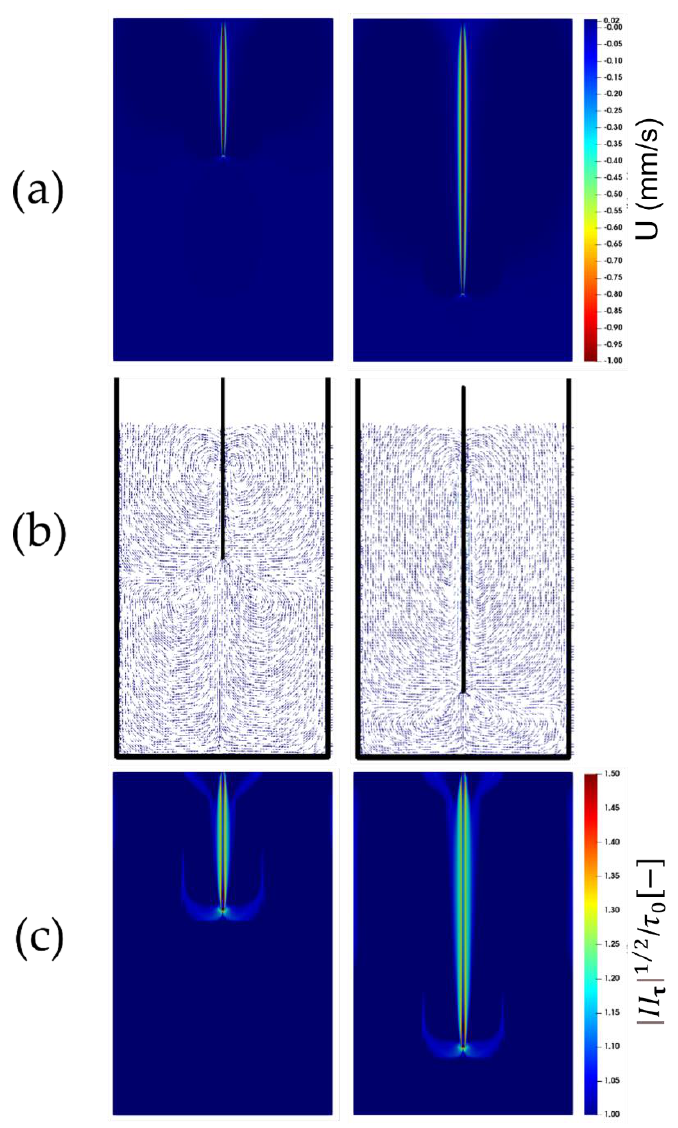
Figure 3. Snapshots of the flow for the plate immersion velocity of 1 mm/s. Parcels on the left-hand side show the immersion after 10 cm, while those on the right-hand side show the immersion after 20 cm. The top contour plots are ( a ) the fluid velocity, and ( c ) the bottom contours are the square root of the second invariant of the viscous stress tensor compared to the yield stress τ 0 . The middle vector ( b ) fields show the velocity vectors within the